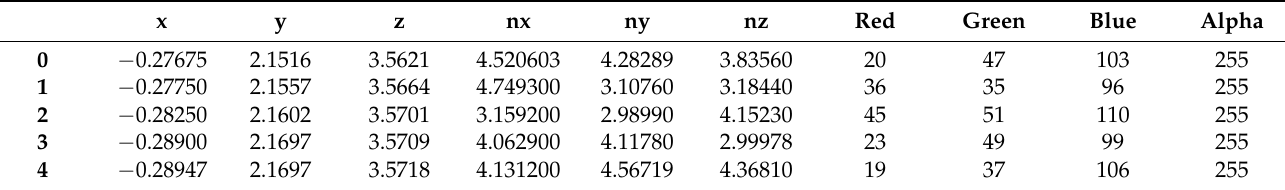
Table 1. Data structure of the point clouds of the weld surface of the steel